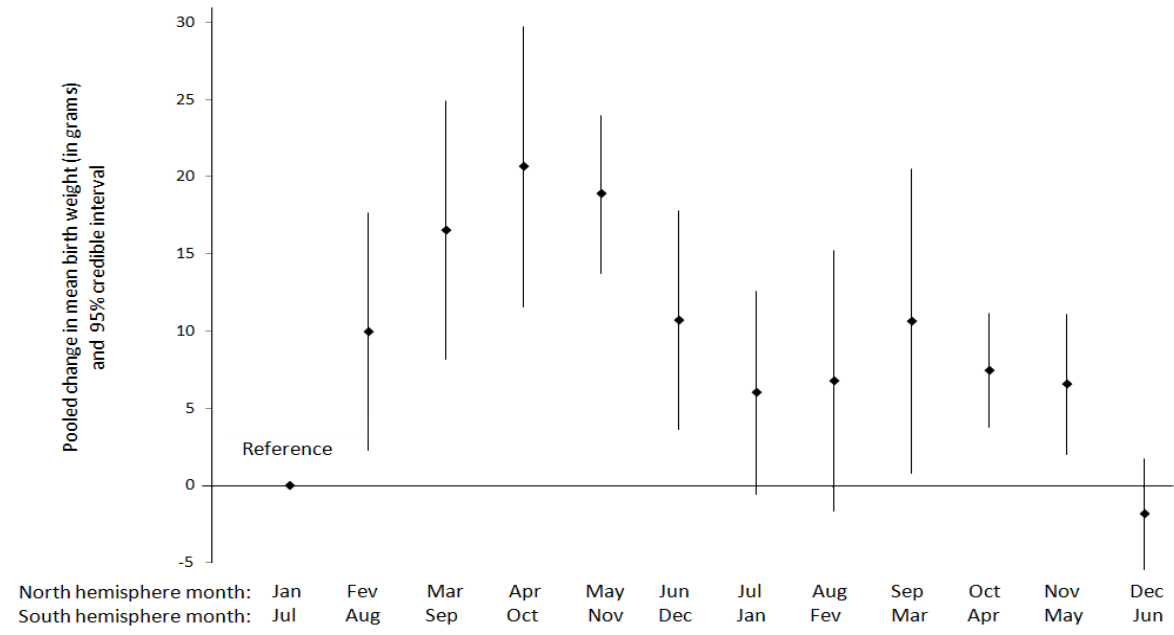
Figure 6. Pooled change in mean birth weight (and 95% credible interval) by month of birth in all infants ( N = 70,652,872